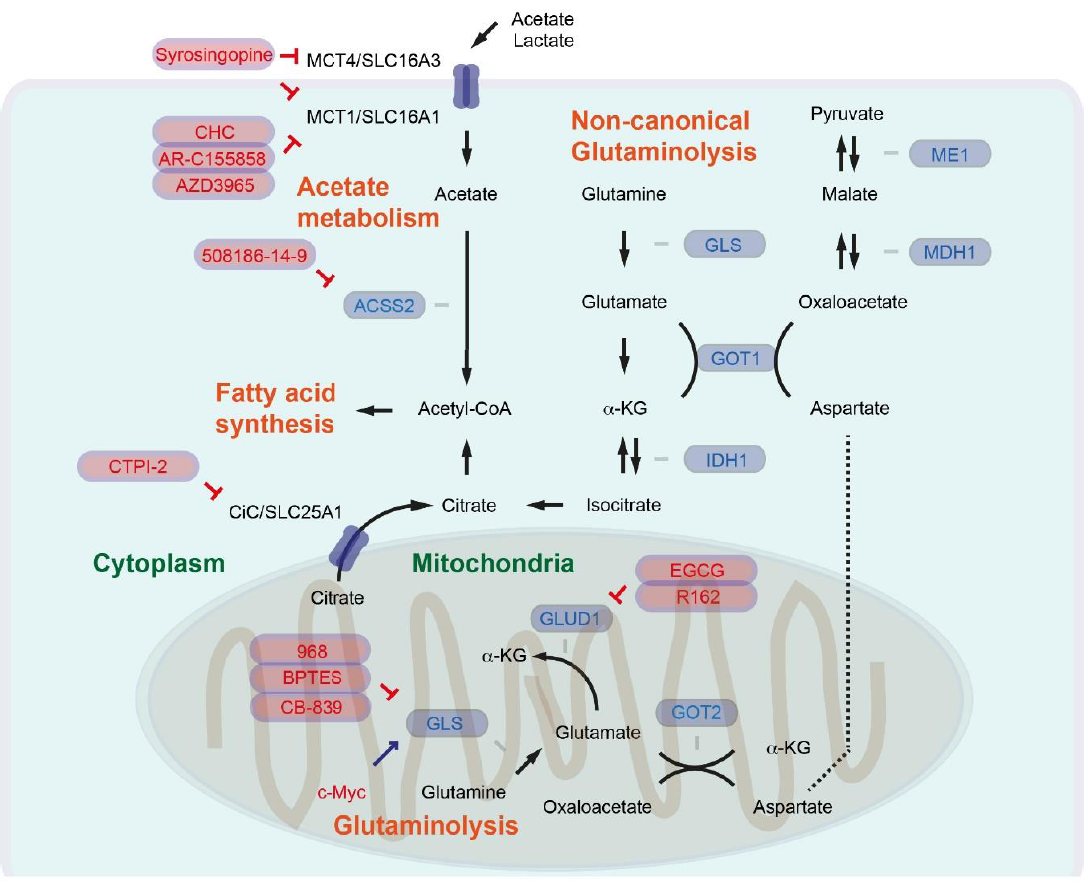
Figure 2. Regulation of glutaminolysis and acetate metabolism. The inhibition symbols are colored in red.